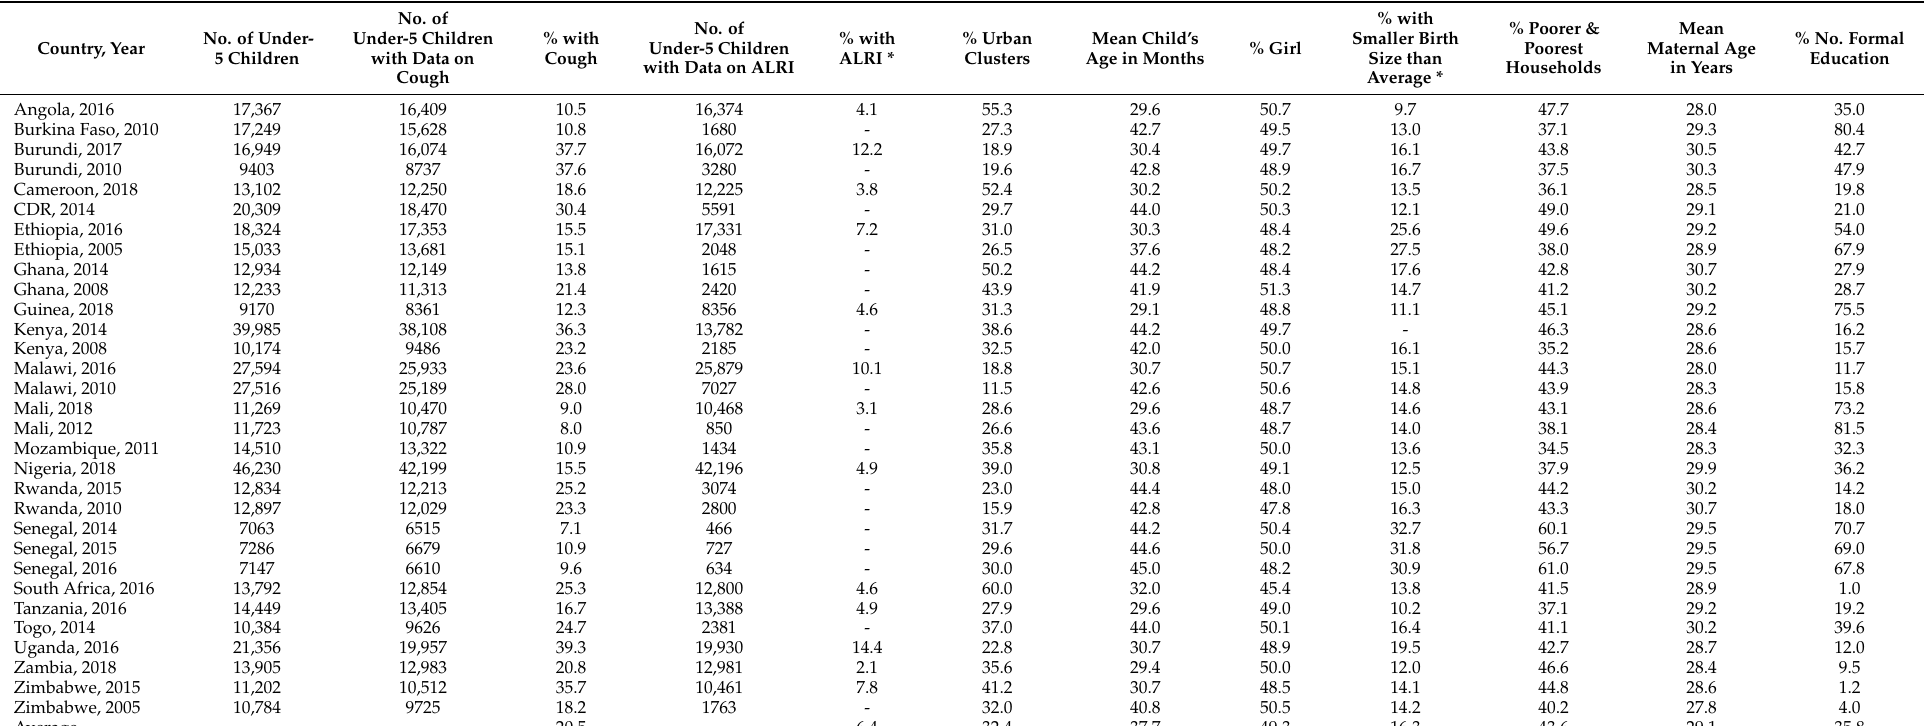
Table 1. Characteristics of study